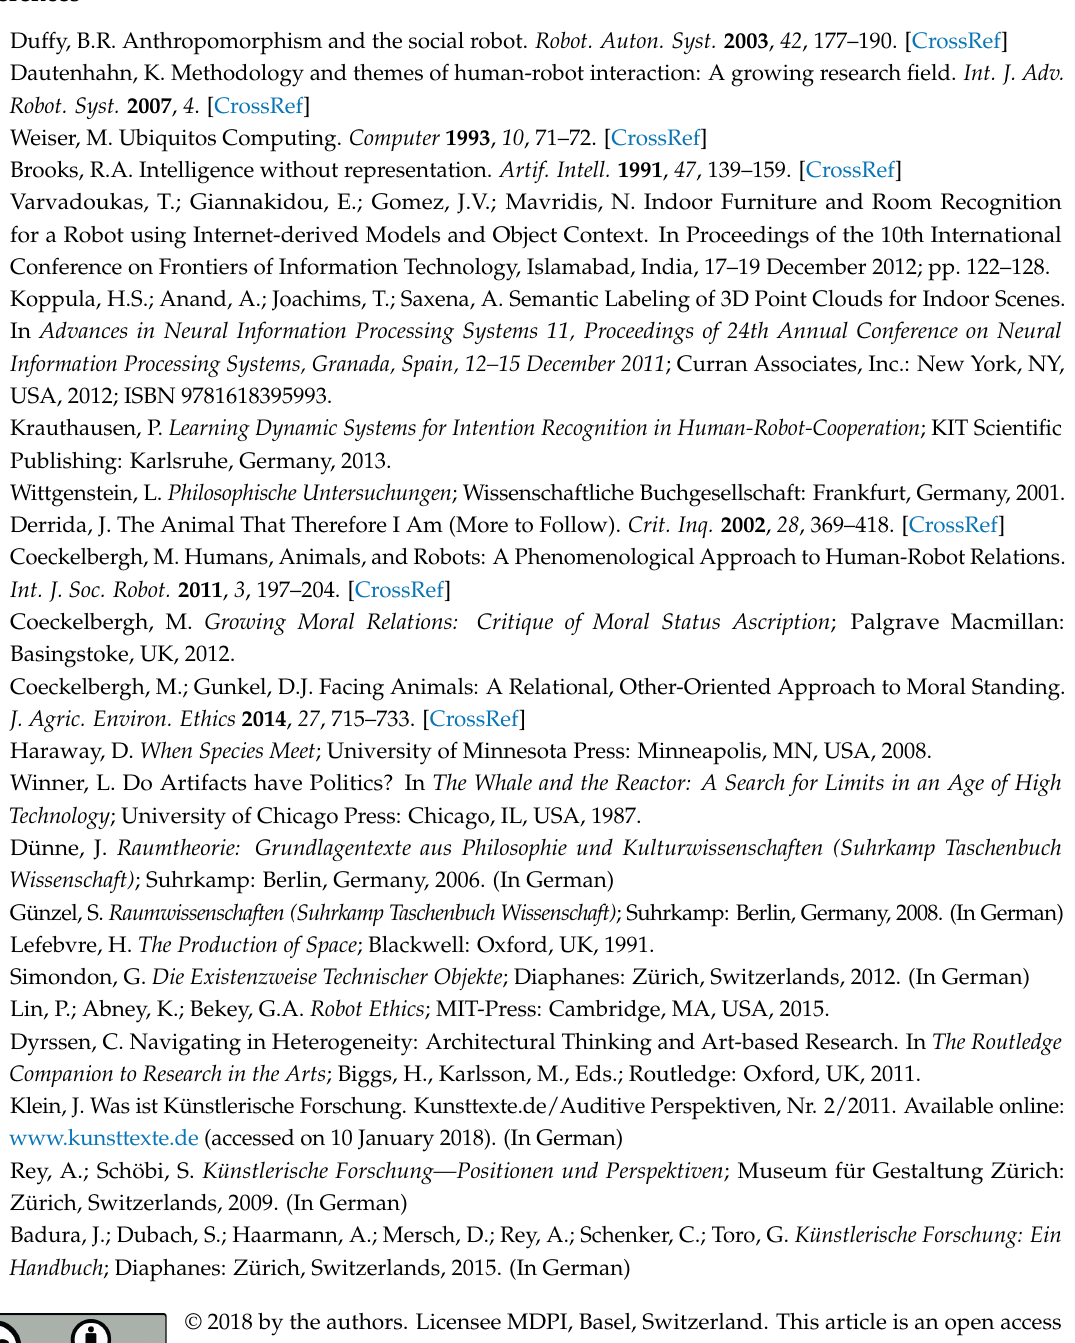
Table S1: Questionnaire data, Code S1: Script